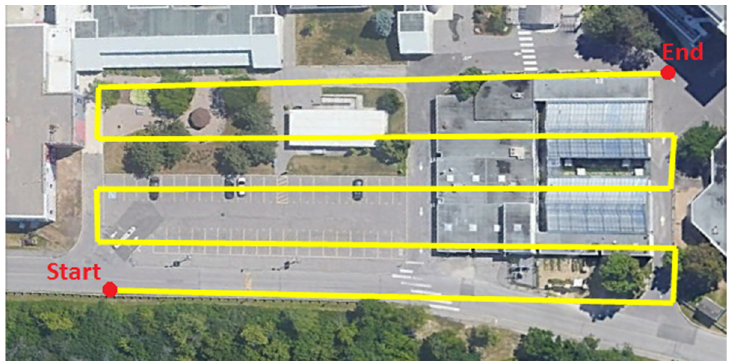
Figure 3. UAS flight lines above the first test site.